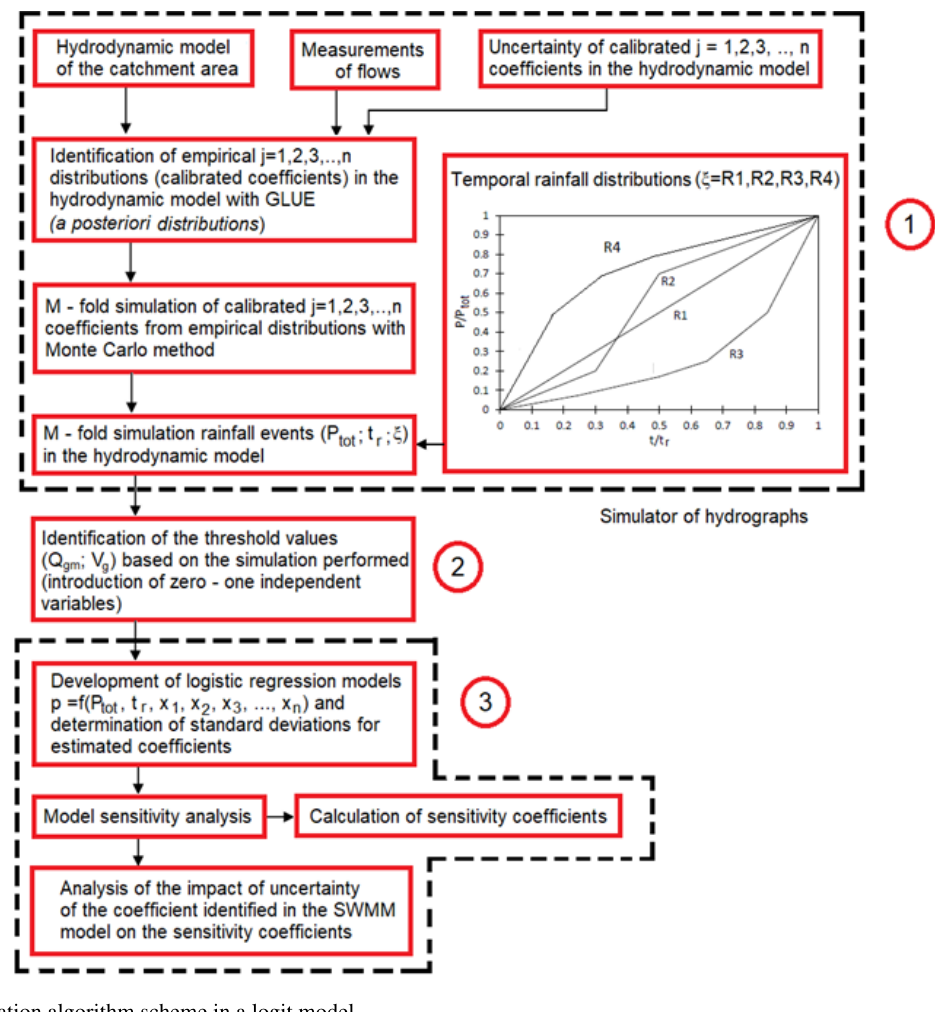
Figure 2. Calculation algorithm scheme in a logit model. Table 1. Ranges of SWMM coefficients (Kiczko et al.,